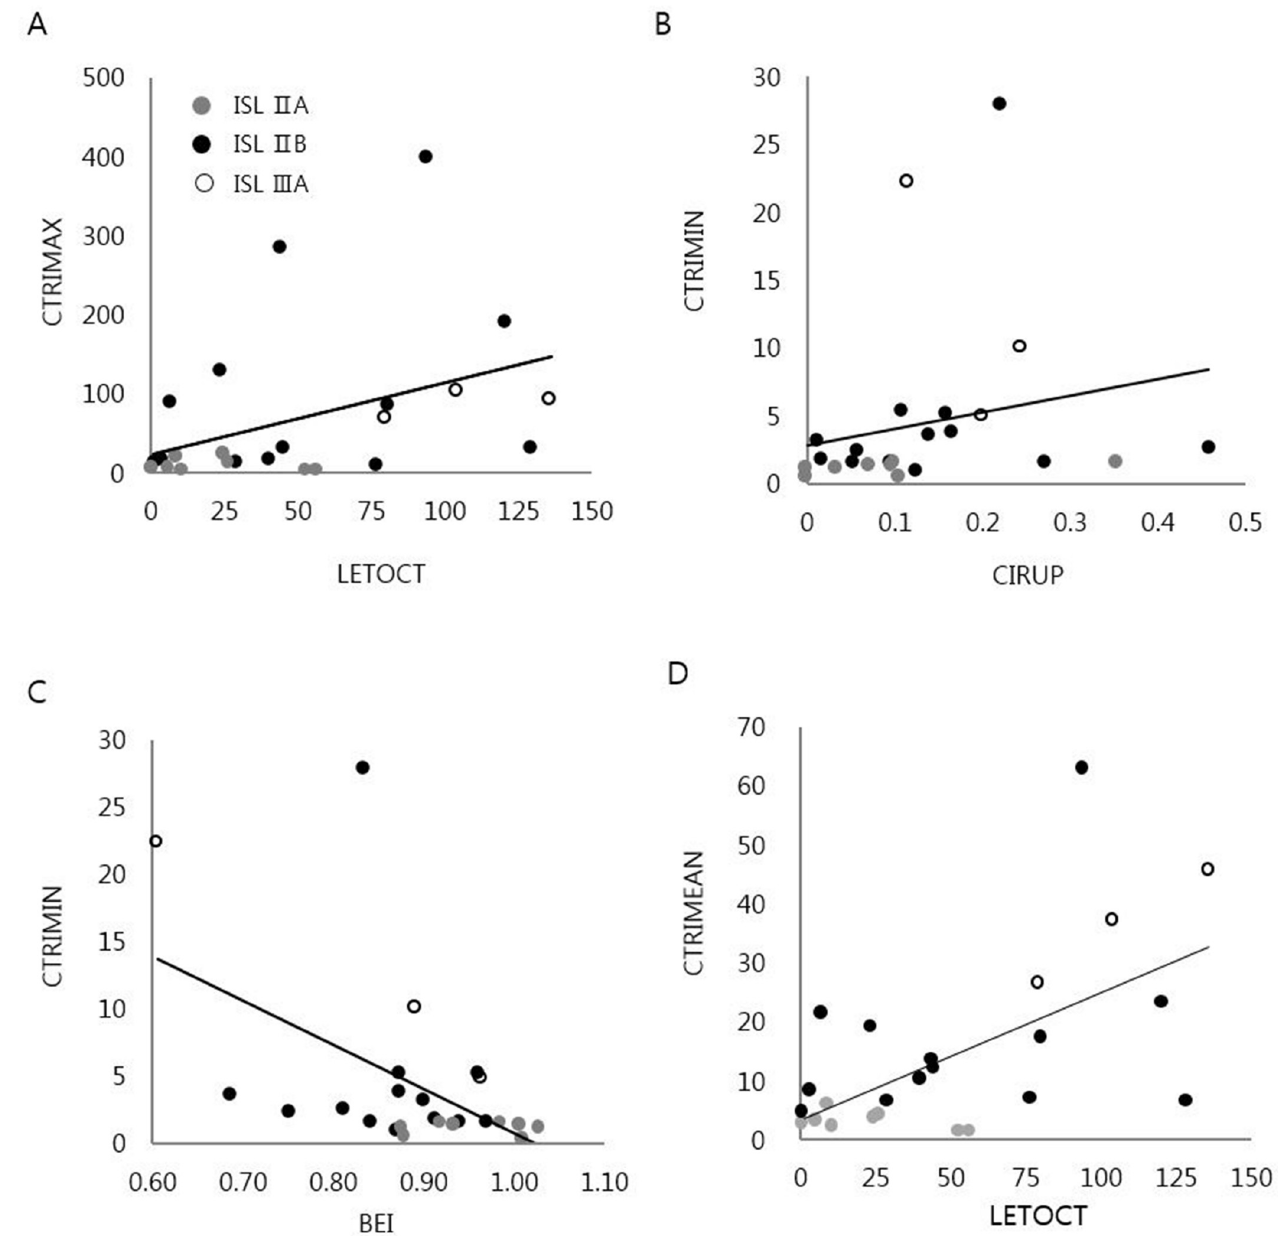
Fig 2. Correlation between the CT reticulation indexes and other clinical measurements. (A) Maximal CT reticulation index (CTRIMAX) showed significant relationship with time from the onset of lymph edema to CT (LETOCT). (B) Minimal CT reticulation index (CTRIMIN) showed significant relationship with difference in the circumference ratio of an affected and nonaffected limb 5 cm proximal to the anatomical landmarks (cm) (CIRUP). (C) CTRIMIN showed significant relationship with 1 kHz-based bio-electrical impedance ratio (BEI) between an affected and nonaffected limb. (D) Mean CT reticulation index (CTRIMEAN) showed significant relationships with LETOCT. Spearman correlation analysis or Mann-Whitney U test.